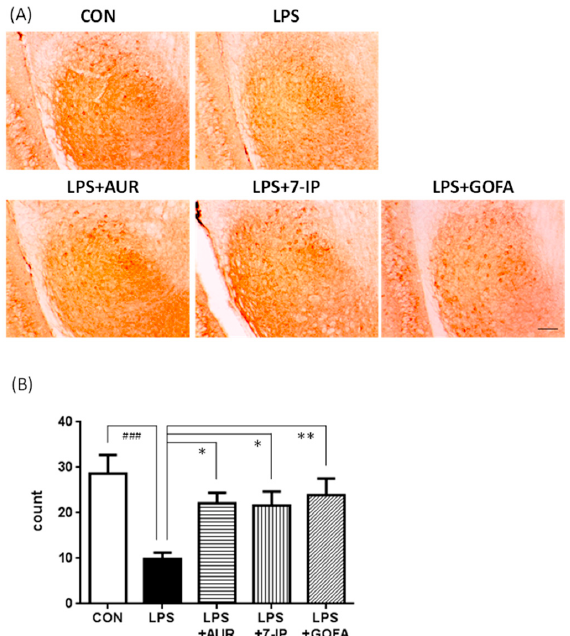
Figure 6. Effects of AUR, 7-IP, and GOFA on LPS-induced neuronal cell loss in the substantia nigra. ( A ) Representative micrographs of GAD67-positive neuronal cells on day 22 in the indicated groups. Scale bar = 100 μ m; ( B ) Total intact cell number of GAD67-positive neuronal cells. Values are the means ± SEM. Significant differences were observed between CON and LPS ( ### p < 0.001) and between LPS and sample treatment groups (* p < 0.05, ** p < 0.01).